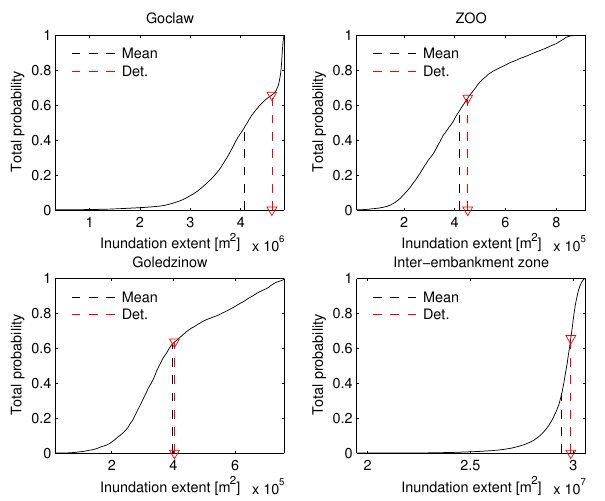
Fig. 8. The marginal cumulative probability density function of wa- ter levels at the MSS model cross-sections (1, 40, 80 and 114) lo- cated along the Warsaw reach of the River Vistula for a 1-in-100 yr flood event flood event; solid lines show the distribution of water Fig. 7. The map of the probability of inundation extent for the ZOO levels obtained using the GLUE framework; red dashed lines show area with superimposed deterministic the deterministic solution; mean values of water levels are shown by black circles.